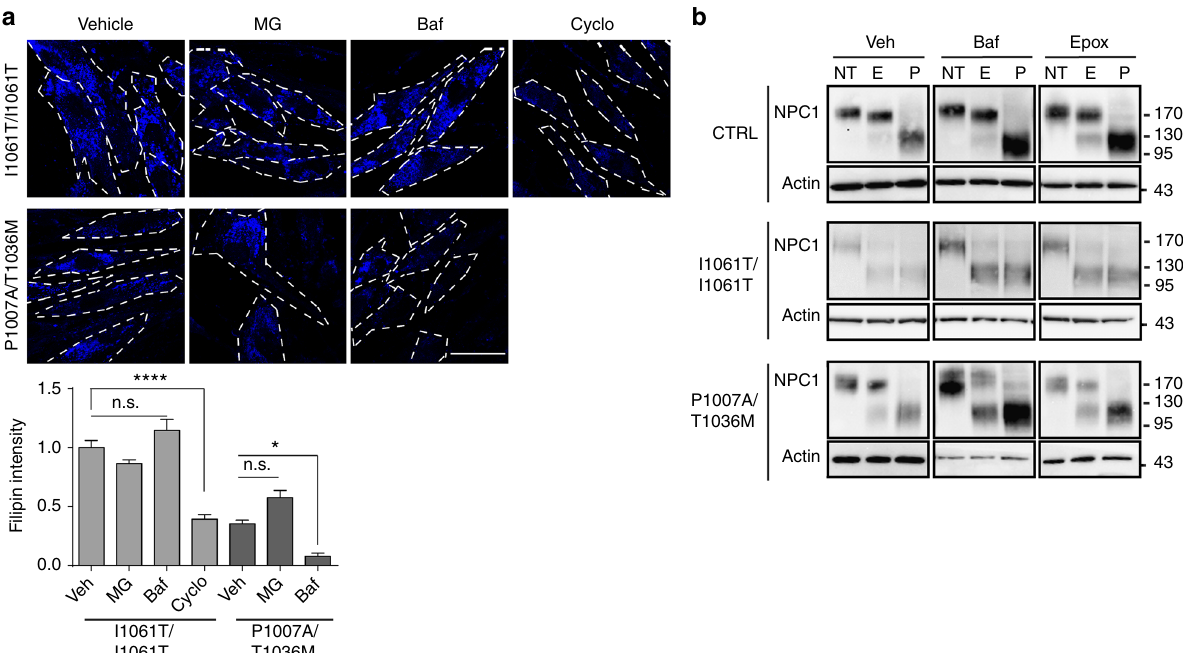
Fig. 3 Accumulating I1061T NPC1 does not traf fi c to lysosomes. a Primary human fi broblasts expressing I1061T or P1007A/T1036M NPC1 were treated for 24 h with vehicle, 10 μ M MG132 (MG), 100 nM ba fi lomycin A1 (Baf), or 1 mM cyclodextrin (Cyclo). Unesteri fi ed cholesterol was labeled with fi lipin (blue), and staining intensity calculated from three independent experiments (16 fi elds/experiment). Scale bar = 50 μ m. Dashed lines outline plasma membrane. Quanti fi ed at the bottom. b CTRL, I1061T, or P1007A/T1036M NPC1 fi broblasts were treated for 24 h with vehicle (Veh), 100 nM ba fi lomycin A1 (Baf), or 100 nM epoxomicin (Epox). Lysates were digested with endoglycosidase H (E), PNGaseF (P), or not treated (NT) and then analyzed by western blot. Data are mean ± s.e.m. n.s., not signi fi cant, * P ≤ 0.05, **** P ≤ 0.0001 by ANOVA with Tukey ’ s posthoc test F =